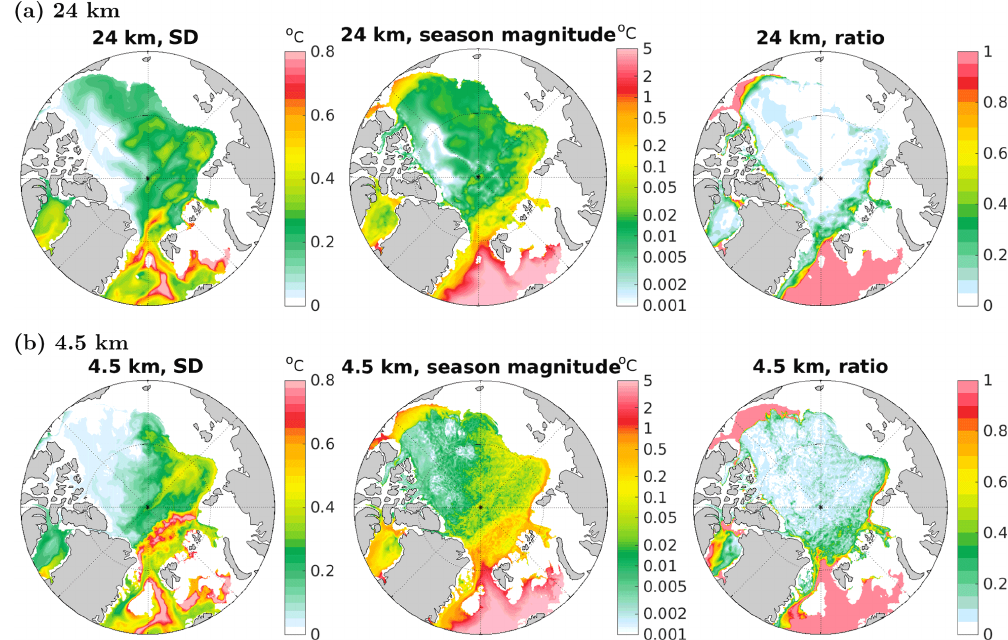
Figure 7. The standard deviation (SD) of the annual mean AWCT (left), the magnitude of the AWCT mean seasonal variability (middle), and the ratio between the seasonal magnitude and the SD of the annual mean (right), in simulations (a) LOW and (b) HIGH for the period of 1980–2009. Note that nonlinear color scales are used in the plots of seasonal